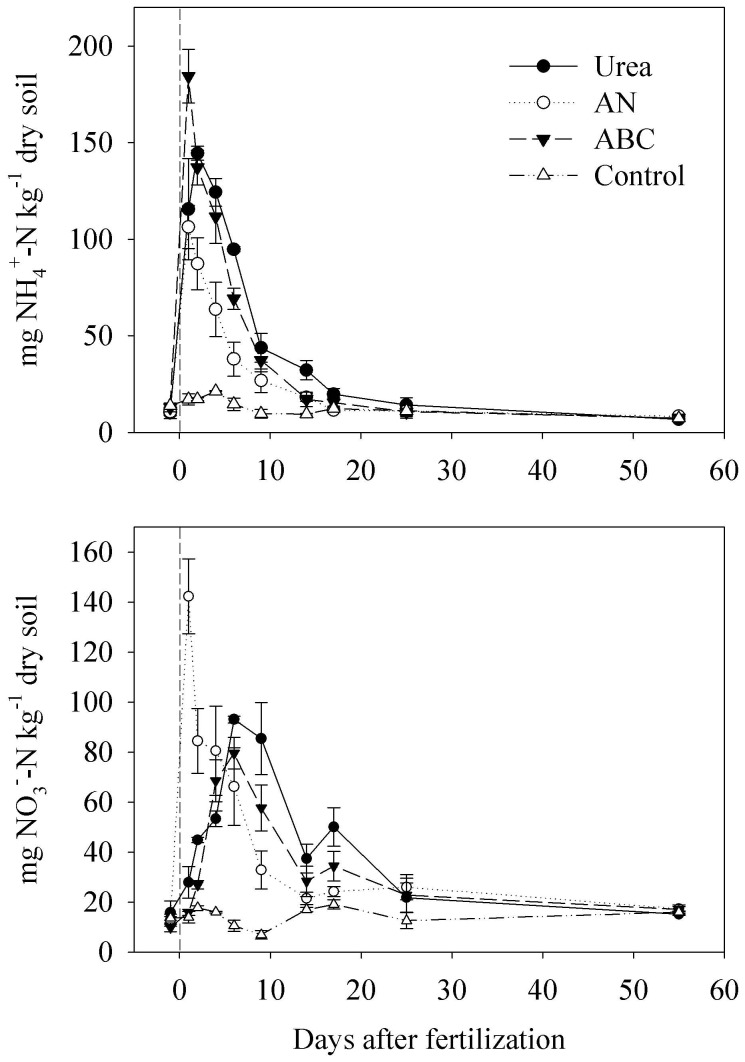
Soil inorganic N pools during the sampling period.Each value is the mean of three replicates, and error bars represent standard errors.